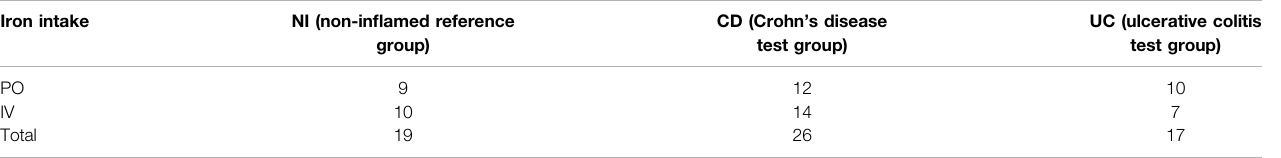
TABLE1| NumberofsamplesofeachcategorythatwereusedintheDivComanalysis.Intotal,19samplesoftheNIgroup,26oftheCDgroup,and17oftheUCgroupwere selected to participate in the study analysis. Iron